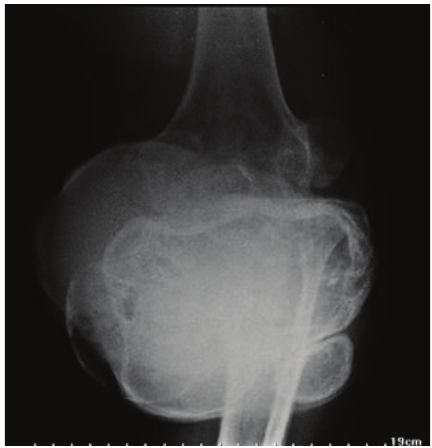
Figure 2: X-ray of the right knee showing osteolytic lesion in proximal tibia.